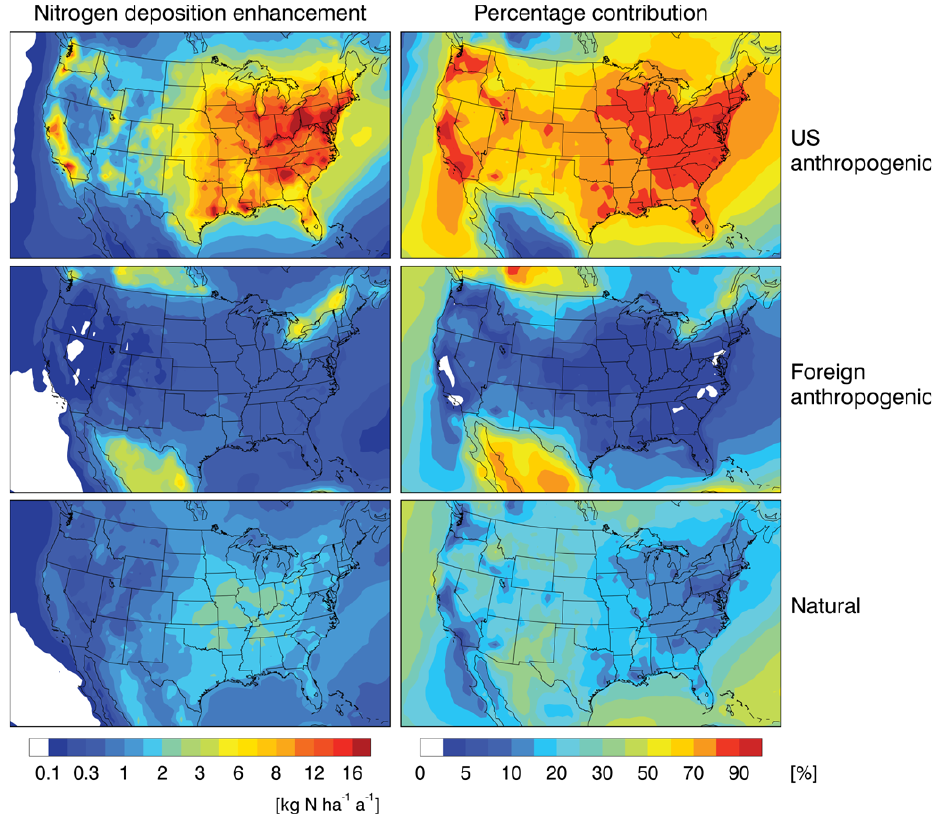
Fig. 10. Domestic anthropogenic, foreign anthropogenic, and natural contributions to annual nitrogen deposition over the contiguous US. Values are from GEOS-Chem sensitivity simulations for 2006 (see text) and are presented as both absolute and relative